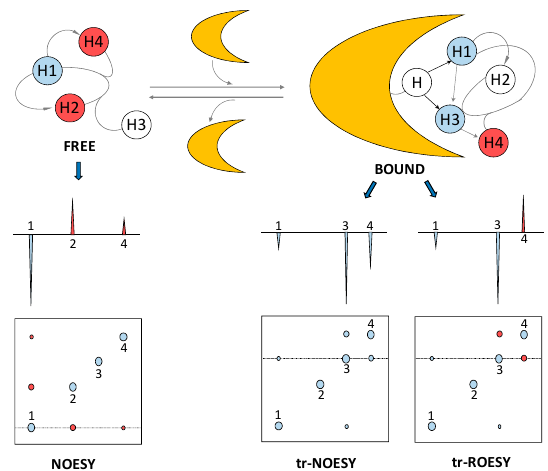
Figure 6. Schematic representation of the trNOESY and trROESY methods for an exchanging ligand-protein (yellow) complex. The NOE cross-peaks of a free ligand are positive (red) and display opposite sign to the negative (blue) diagonal (auto) peaks, but upon interaction with the protein in a trNOE experiment, these peaks also become negative due to the increase of effective rotational correlation time. The analysis of the negative cross-peaks provides information on the bound conformation of the ligand. The possible spin-diffusion-related trNOE cross-peaks can be identified by trROE where the alternation of the sign is diagnostic of the real and artifact